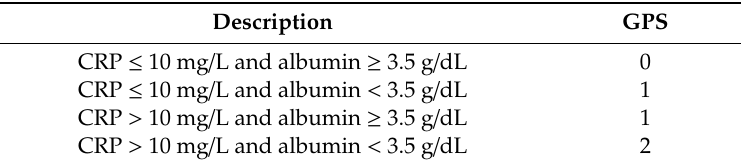
Table 4. Description of the preoperative GPS. Abbreviations: GPS, Glasgow Prognostic Score; CRP, C-reactive